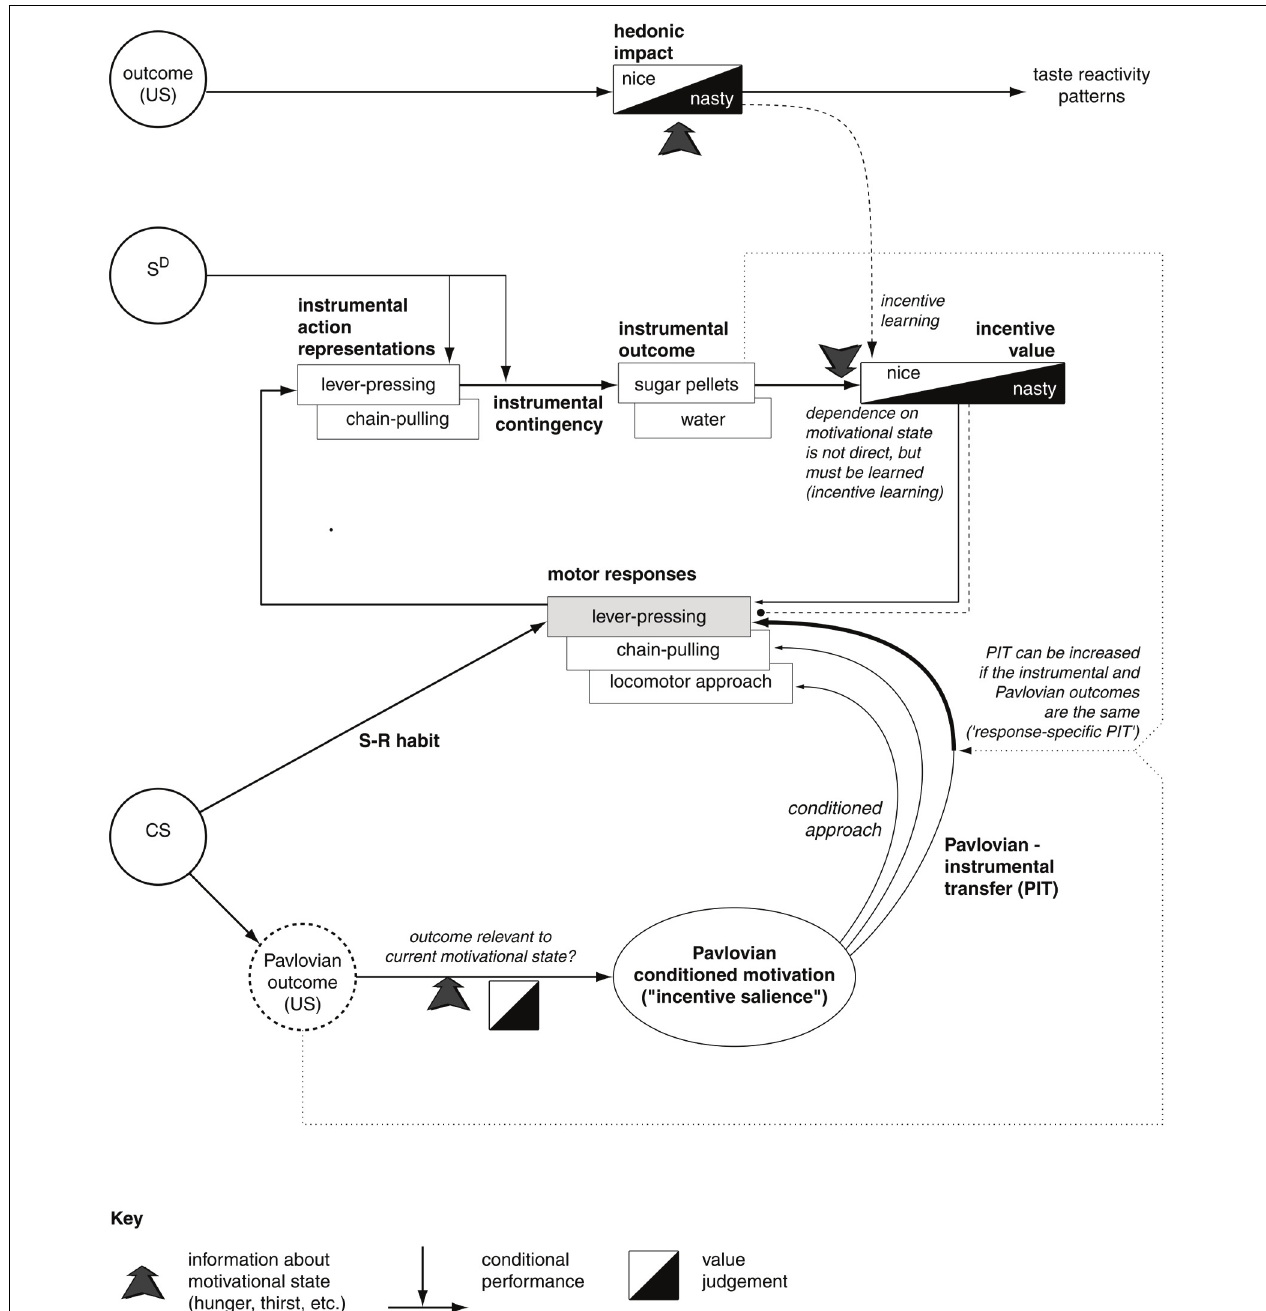
FIGURE 1 | The major associations and processes behind instrumental habitual behavior, goal-directed behavior, Pavlovian processes, and their relations (here we describe only those relevant for this work). At the top, the diagram shows the systems processing the hedonic impact and the incentive value of stimuli, the latter important for the assignment of value to appetitive/aversive stimuli involved in goal-directed processes. The middle of the diagram shows the loop of processes involving goal-directed behavior; here the action representations are associated with outcome representations (instrumental contingency) and then these outcomes are attributed incentive value. In this way, outcomes can trigger the execution